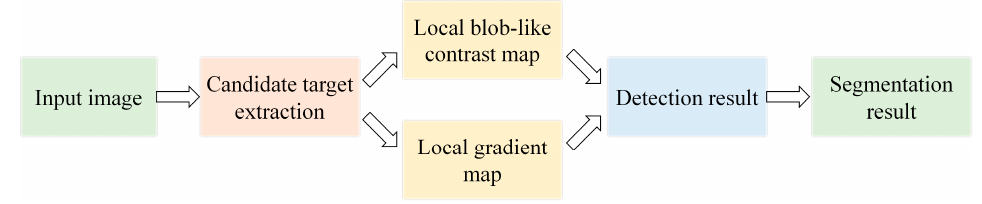
Figure 1. Framework of the proposed IR small target detection method.